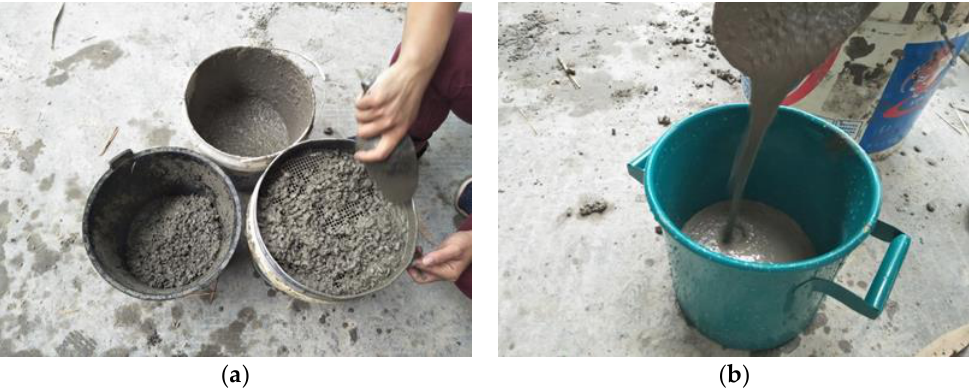
Figure 11. The procedure before the penetration resistance test. ( a ) Coarse aggregate was removed; ( b ) remaining mortar was poured into the barrel.